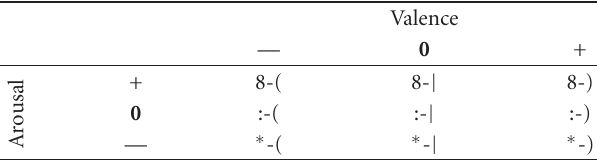
Table 3: Ad hoc emoticons used to represent positions in the arousal-valence